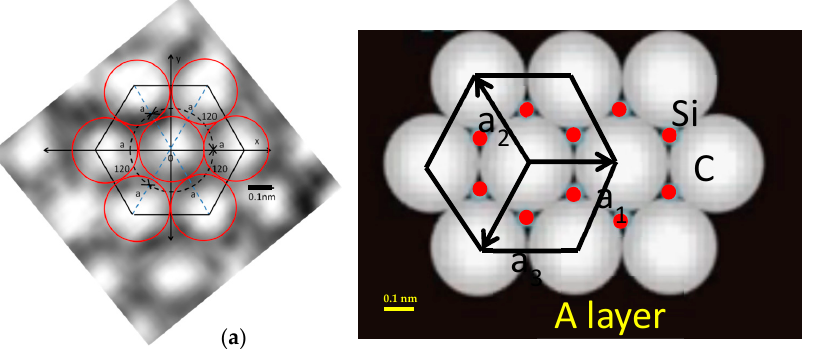
Figure 4. ( a ) Elementary cell of hexagonal packing identified in the HRTEM pattern resembling theoretical structure shown in ( b ).